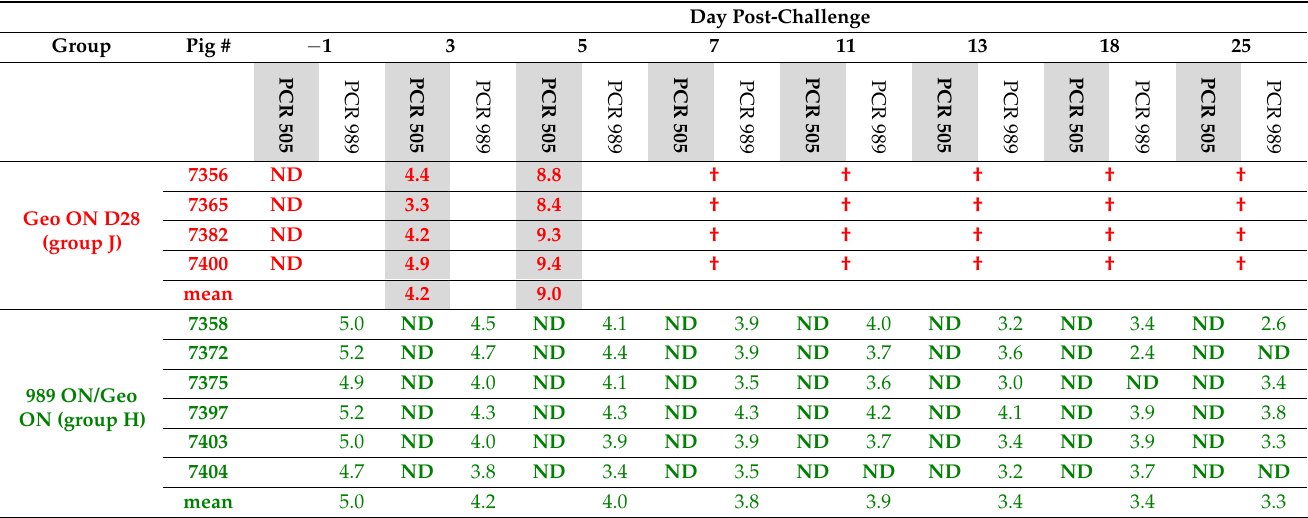
Table 3. Detection of ASFV-989 and Georgia viremia after ON Georgia strain challenge of immunized or nonimmunized pigs (D28